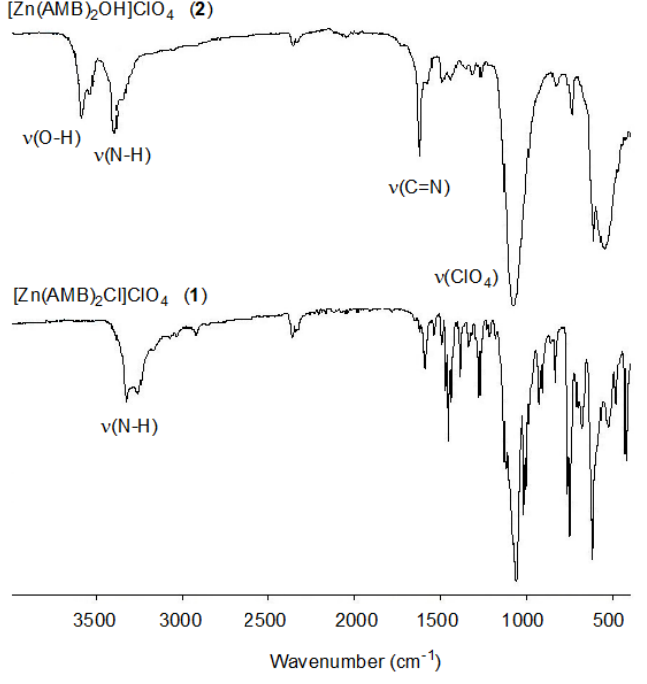
Figure 2. FTIR spectra of zinc(II) model complexes [Zn(AMB) 2 Cl](ClO 4 ) 1 and [Zn(AMB) 2 (OH)](ClO 4 ) 2 .